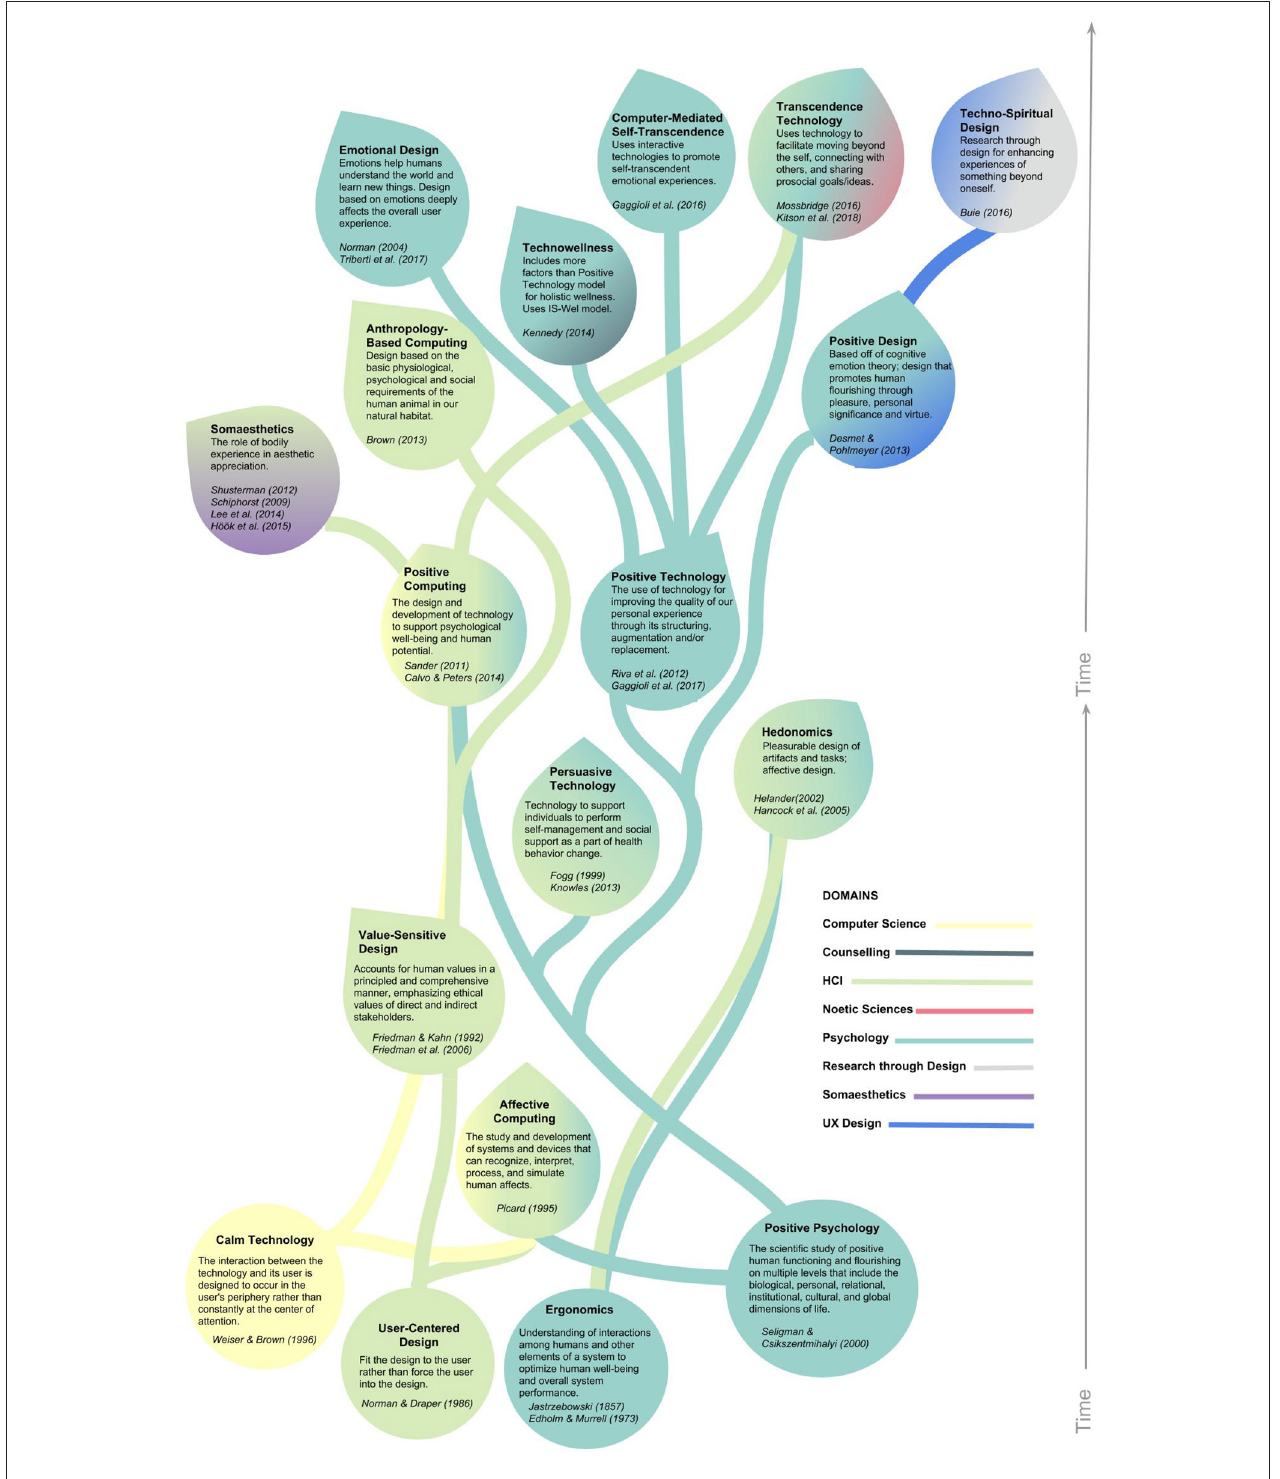
FIGURE 1 | Existing domains of technology for positive functioning and well-being: moving along the y-axis is the passage of time on a non-linear scale that depicts the growth of different fields that stem from the foundational three domains of Computer-Science, HCI, and Psychology. Each color represents a different domain; the stems show the progression of the domain, feeding into the next; and the leaves are colored by the influences from those domains. Leaves represent the first conceptualization of an approach, and do not imply the cessation of progress, e.g., Affective Computing was first introduced in the 1990s and is still relevant today.